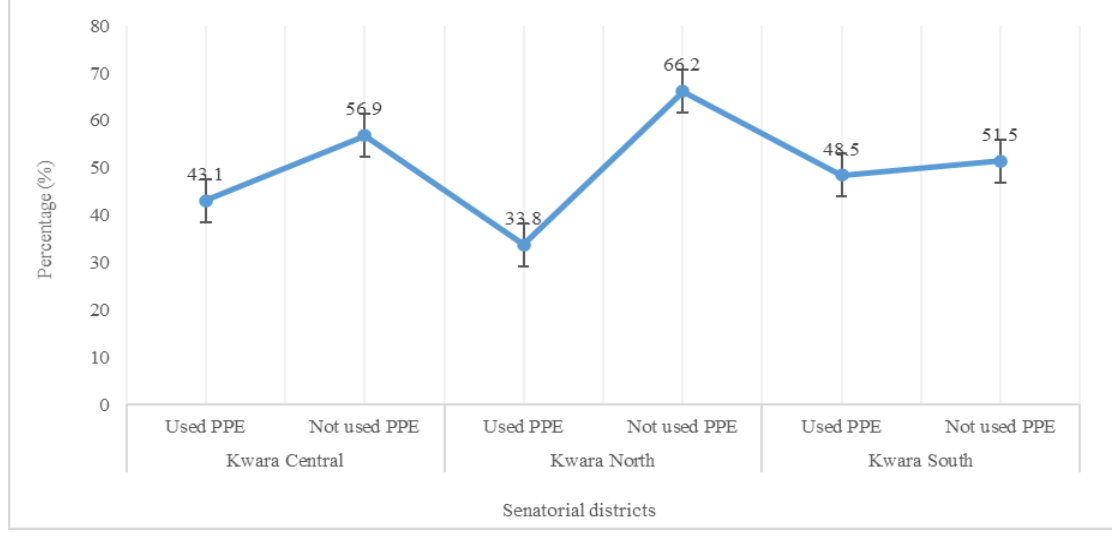
Figure 5. Compliant to PPE usage across the three senatorial districts.